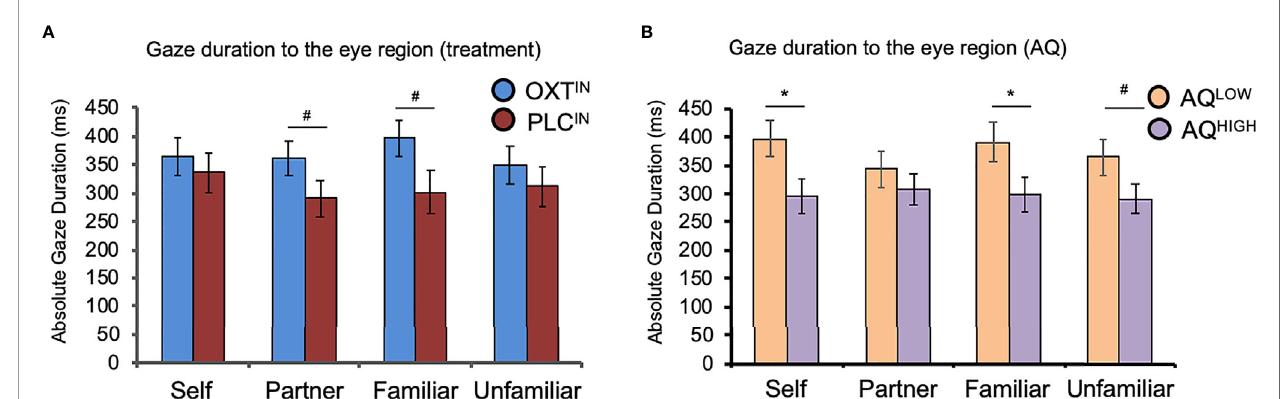
FIGURE 3 | The effects of oxytocin (OXT) and autistic-like traits measured with the Autism-Spectrum-Quotient (AQ) on visual attention to the eye region of faces. (A) The effects of intranasal OXT on gaze duration toward the eye region across the four different categories of facial stimuli. Intranasal OXT increased the tendency to spend more time looking toward the eye region of the romantic partner ( “ partner ” ) and a close friend ( “ familiar ” ). (B) The effects of AQ on visual attention to the eye region across the four different categories of facial stimuli. Independent of treatment, individuals in the AQ-high group spent less time looking towards the eye region of their own face, as well as the familiar and unfamiliar person. OXT IN , oxytocin nasal spray; PLC IN , placebo nasal spray; AQ, Autism-Spectrum-Quotient; ms, milliseconds. Error bars indicate the standard error of the mean (SEM). # P < 0.10; * P <